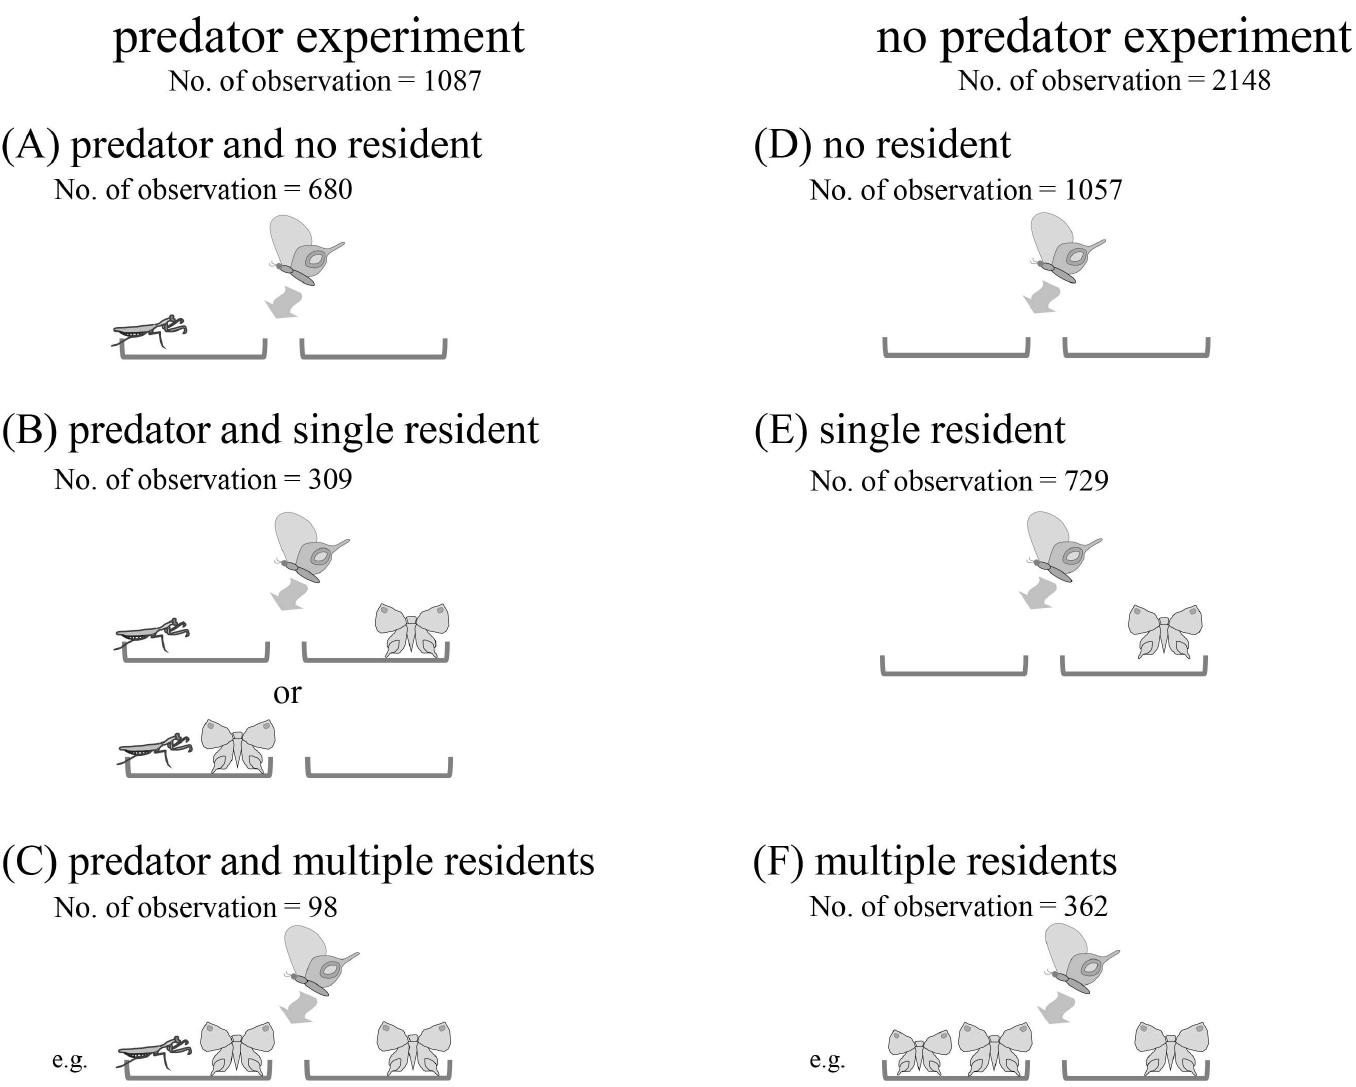
Fig 2. Schematic figures of data classification in the predator(A-C-) and the no-predator experiments